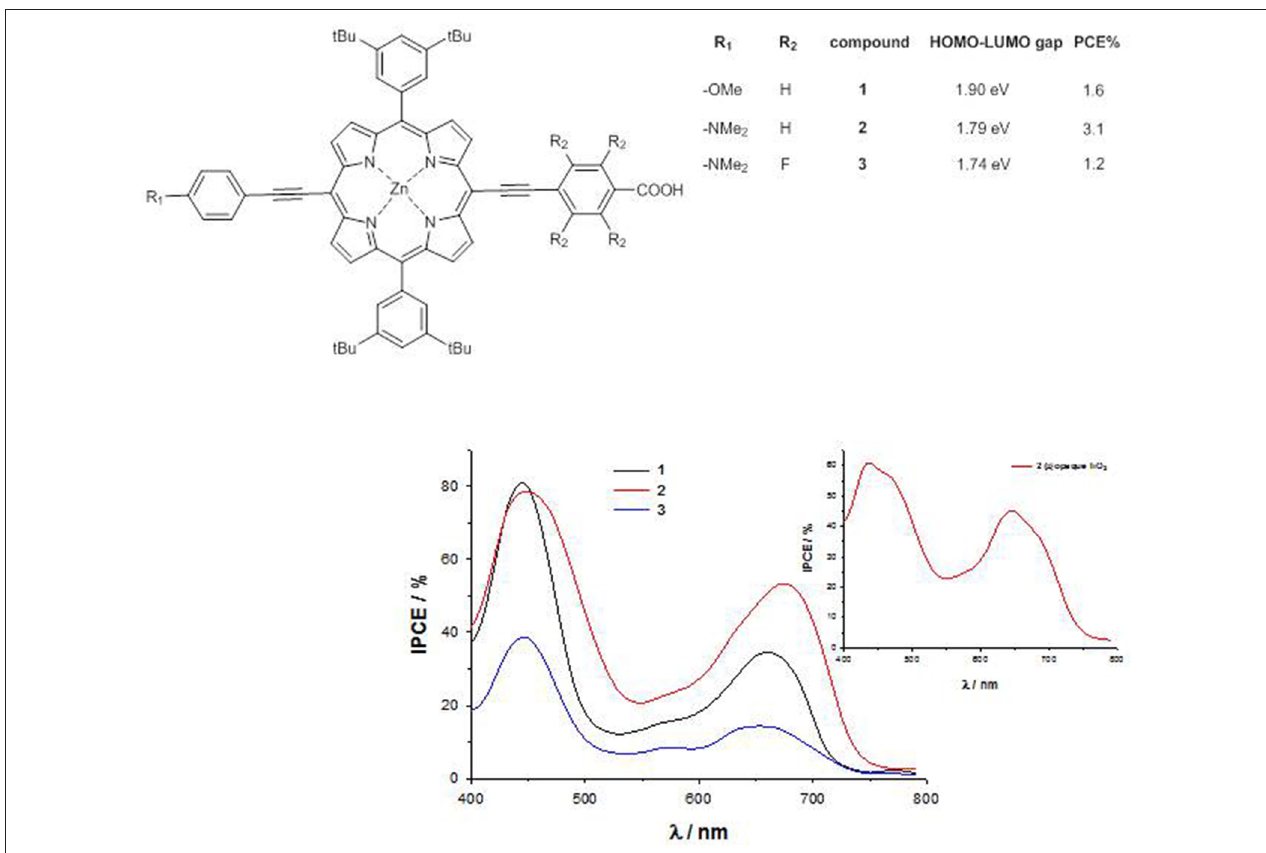
FIGURE 3 | trans -A 2 BC push-pull Zn II porphyrins 1-3 and their IPCE spectra.